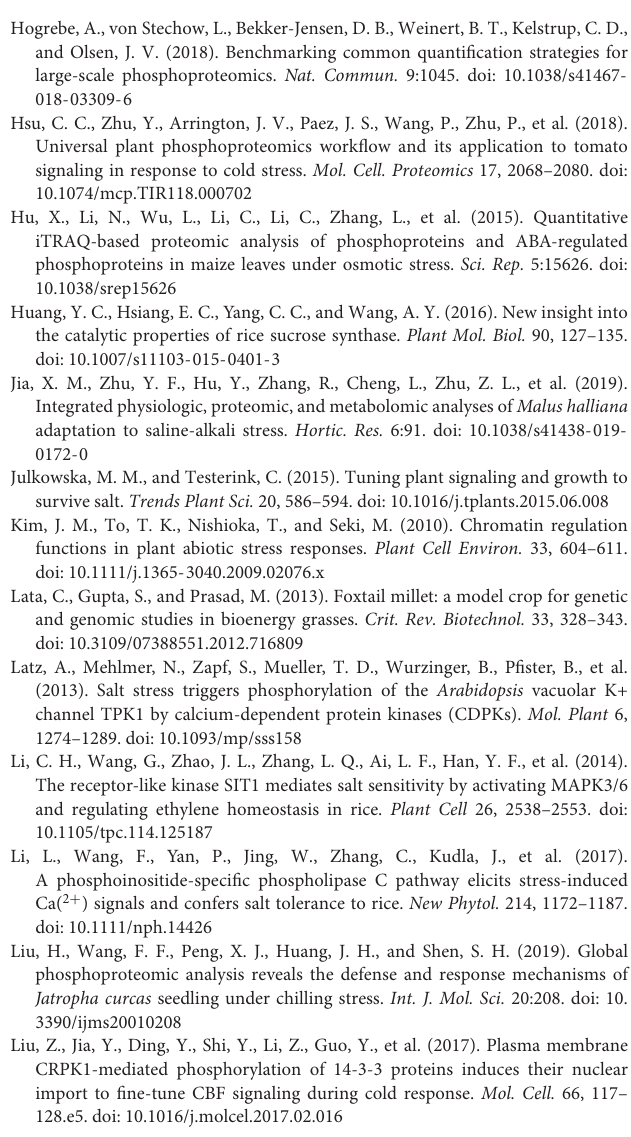
Supplementary Table 2 | The statistics and list of differentially abundant proteins (DAPs) in four comparison groups, AN04TvsAN04C, YG2CvsAN04C, YG2TvsAN04T, and YG2TvsYG2C. Supplementary Table 3 | The statistics and list of differentially regulated phosphoproteins (DRPPs) in four comparison groups, AN04TvsAN04C, YG2CvsAN04C, YG2TvsAN04T, and YG2TvsYG2C. Supplementary Table 4 | KOG and subcellular location statistics and list of DAPs in four comparison groups, AN04TvsAN04C, YG2CvsAN04C, YG2TvsAN04T, and YG2TvsYG2C. Supplementary Table 5 | KOG and subcellular location statistics and list of DRPPs in four comparison groups, AN04TvsAN04C, YG2CvsAN04C, YG2TvsAN04T, and YG2TvsYG2C. Supplementary Table 6 | GO functional cluster statistics and list of DAPs in the biological process in four comparison groups, AN04TvsAN04C, YG2CvsAN04C, YG2TvsAN04T, and YG2TvsYG2C.